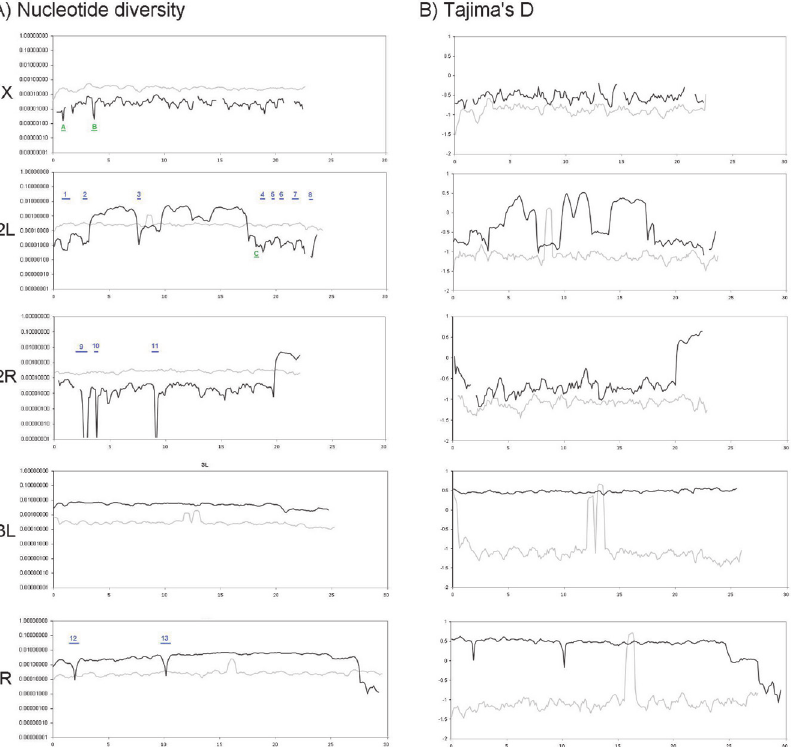
Fig 1. Estimates of (A) nucleotide diversity (pi; π ) and (B) Tajima's D ( D ) across the chromosome arms of Drosophila melanogaster from the DDT resistant 91-R strain (black line) and DDT susceptible 91-C strain (grey line). Metrics obtained from 500-kb sliding windows with a step size of 100-kb. The genes identified to be associated with each of the major selection sweeps are as follows: (1) CG42329, (2) CG15394, (3) NinaC , (4) CG6453, (5) CG17568 and Ref(2)P , (6) RtGEF , (7) CG12050, CG8677, and Dtr , (8) CG31612, (9) Dscam1 , (10) Sut1 , (11) MDR49 , (12) CG1041 and (13) CG31495. The genes identified to be associated with each of the minor selection sweeps are as follows: (A) Cyp4g1 ; (B) AlstR , Mnt and Fd3F ; and (C) Kon